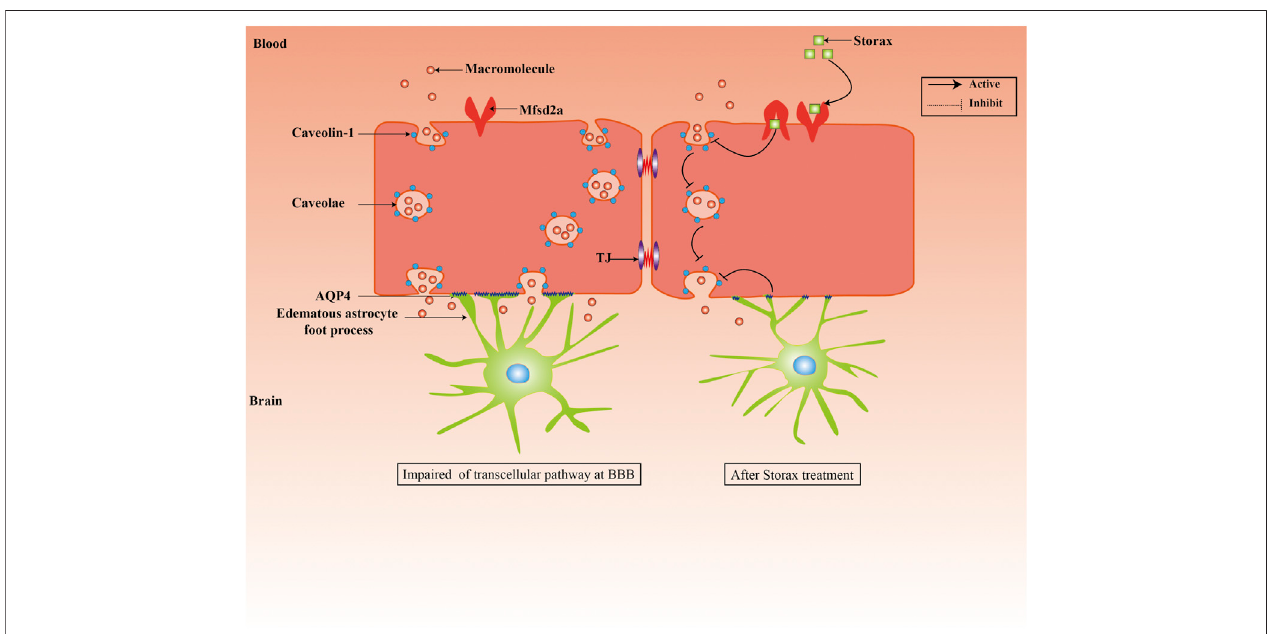
FIGURE 6 | Schematic representation of effects of Storax on caveolae-mediated transcytosis at BBB and its potential molecular mechanisms.